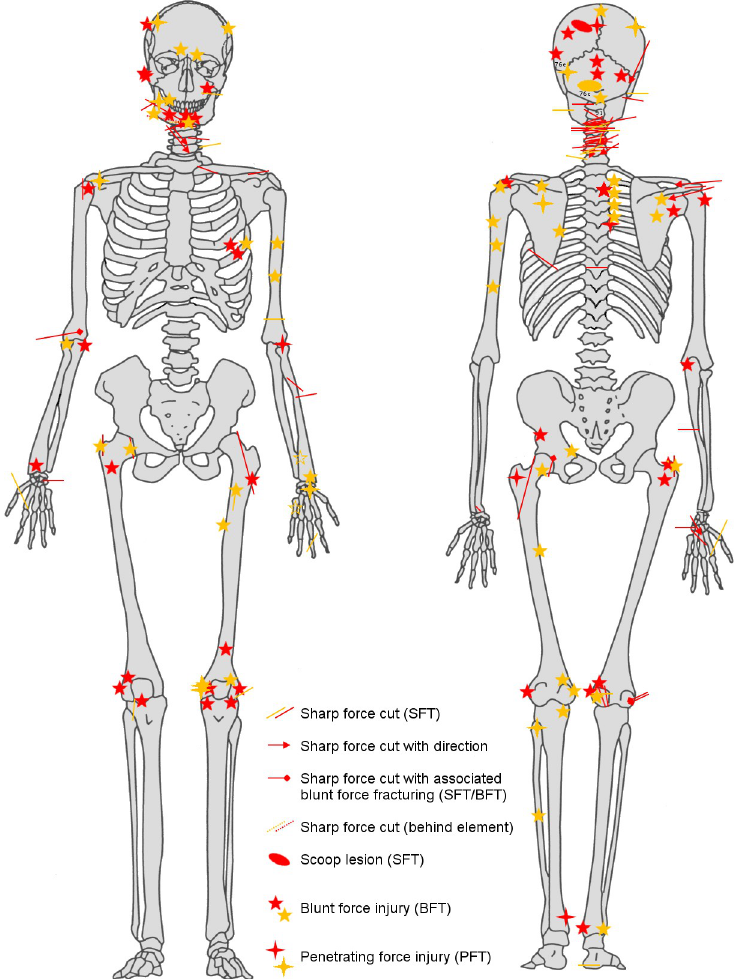
Fig 4. Distribution of all definite (red) and probable (yellow) perimortem trauma evidenced in the skeletal group deriving from burials 101 and 110 as a whole (image: R. Mikulski). See also S1 Table for crude prevalences of trauma types by body